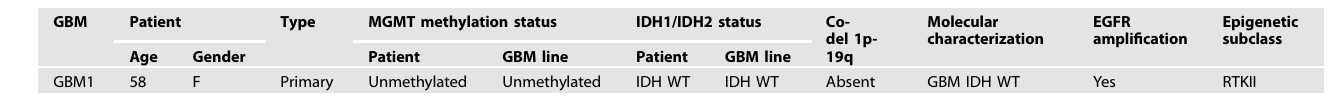
Table 1. Molecular characteristics of primary cell line.